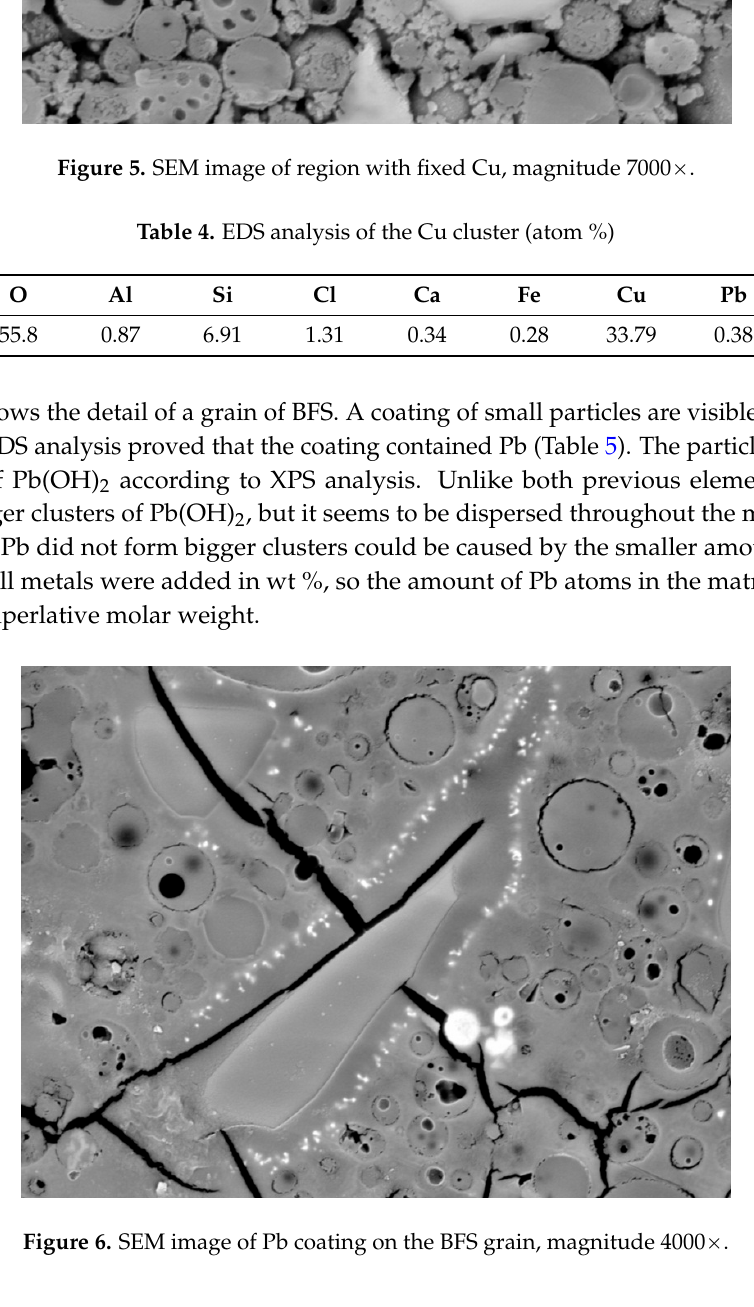
Figure 6. SEM image of Pb coating on the BFS grain, magnitude 4000×. Table 5. EDS analysis of the Pb coating (atom %).